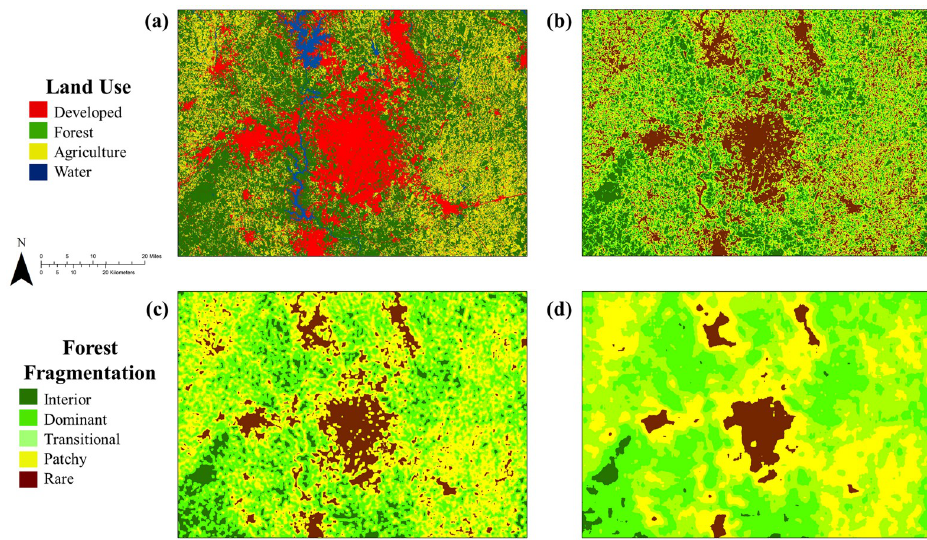
Fig 5. Forest fragmentation classes. (a) Land use around Charlotte, North Carolina, United States, and corresponding forest fragmentation classes for (b) 3x3, (c) 9x9, and (d) 27x27 pixel windows. See Table 3 for definitions for the specific